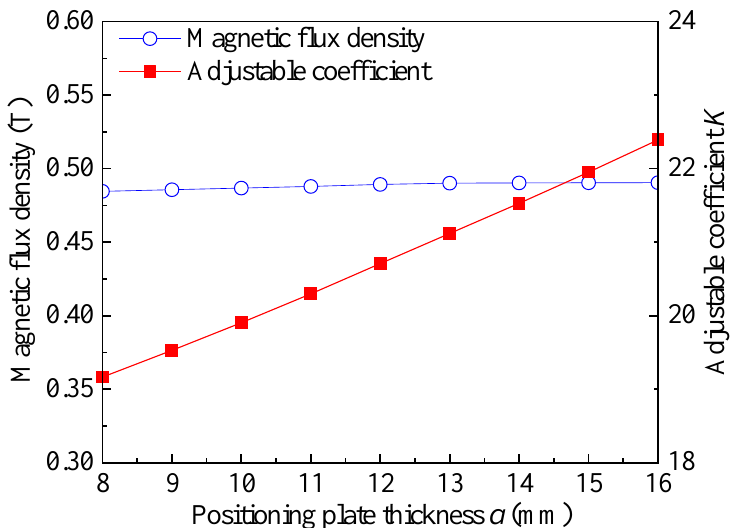
Figure 14. Magnetic flux density and adjustable coefficient under different thickness of positioning plate.